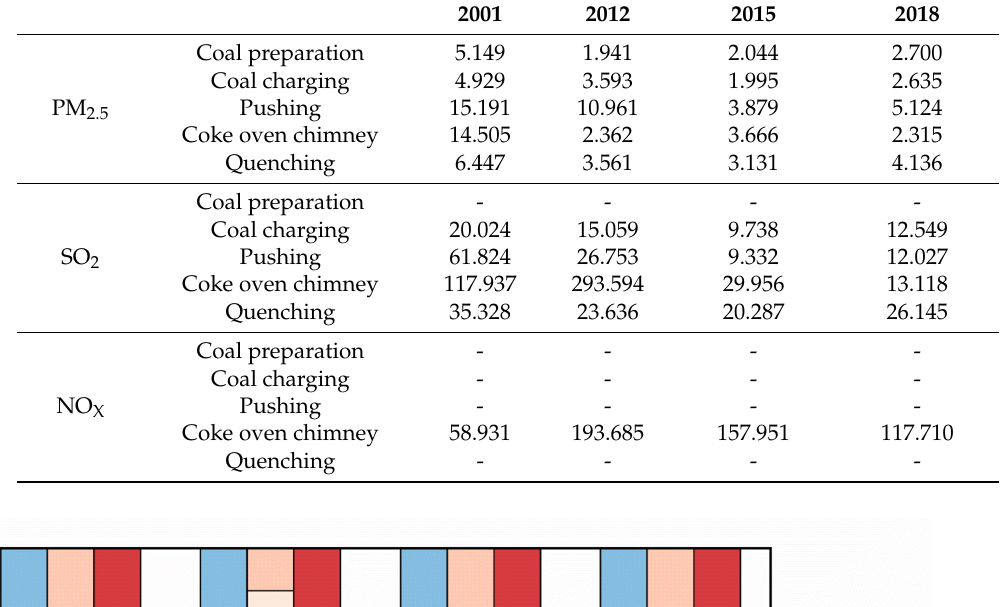
Table 1. Emissions of PM 2.5 , SO 2 , and NO X from each component of the procedures of China’s independent coking industry in 2001, 2012, 2015, and 2018 (unit: Gg).